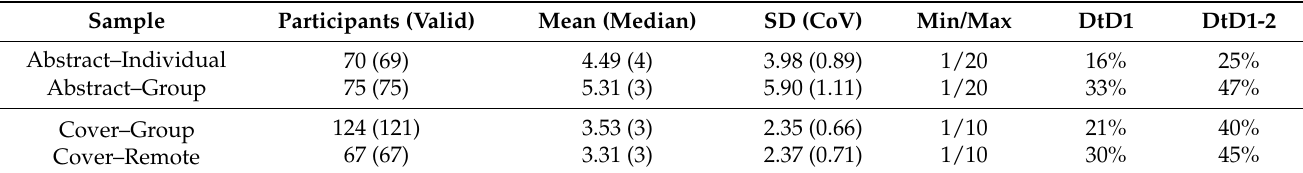
Table 1. Descriptive statistics per